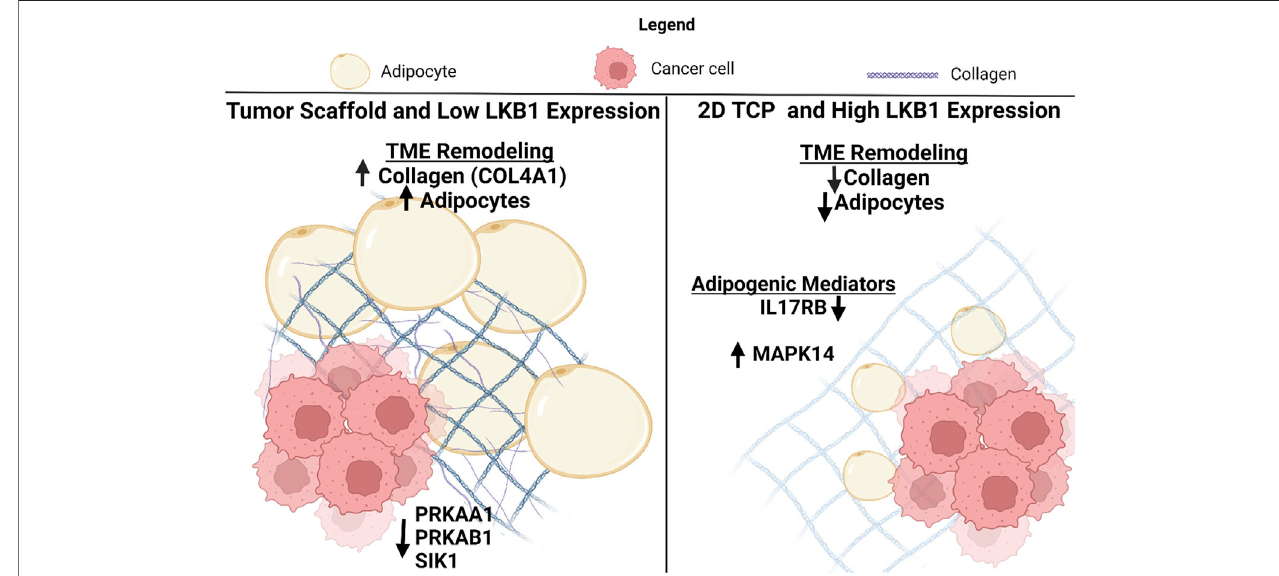
FIGURE 5 | Schematic for the suggested role of LKB1-mediated TME remodeling in TNBC. Created with BioRender.com.